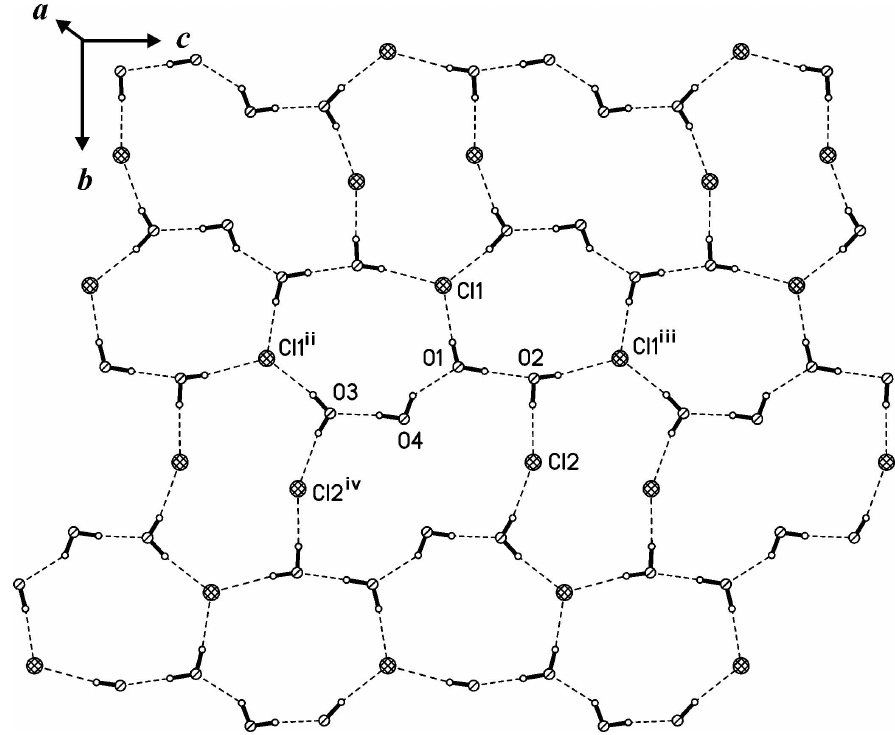
Figure 3 The two-dimensional water-chloride framework parallel to (100). [Symmetry codes: (ii) - x , - y + 3/2, z - 1/2; (iii) - x , - y +